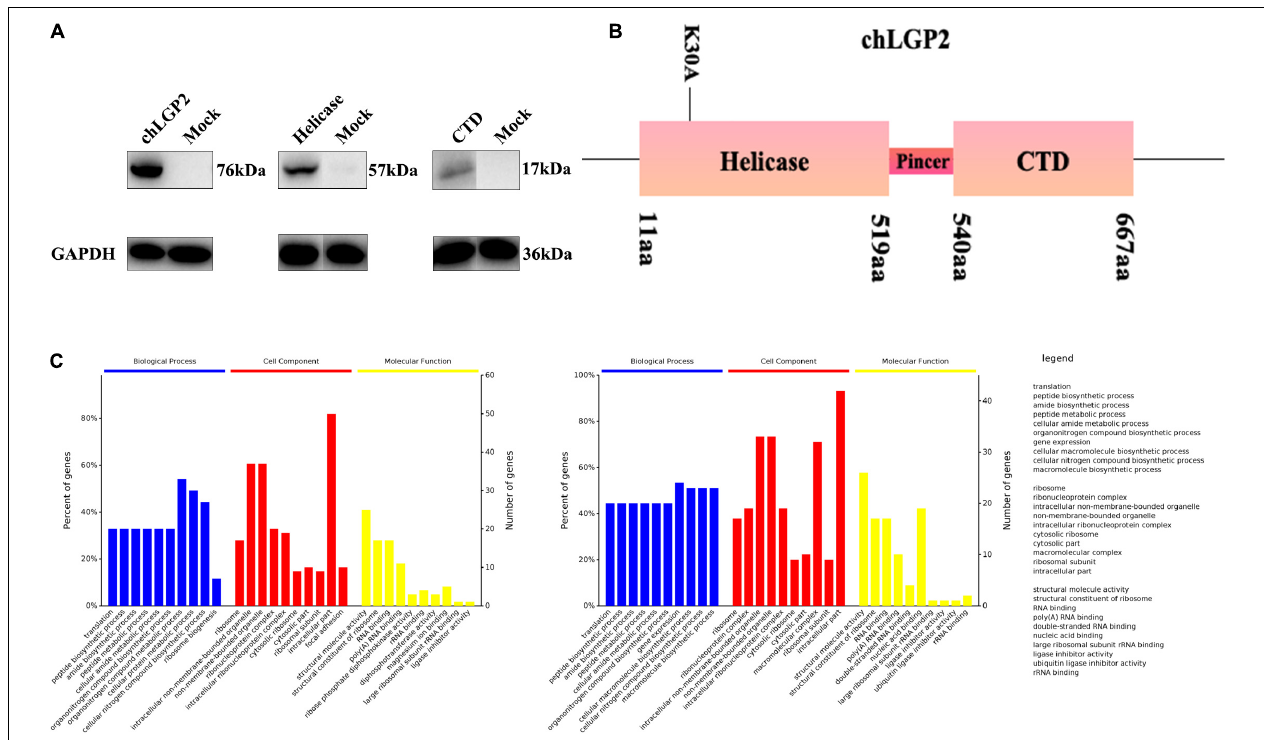
FIGURE 4 | The interaction between chLGP2 and chTRBP and the expression of chLGP2 domains. (A) Extracellular expression of chLGP2, Helicase domain, and CTD. (B) Schematic of different domains and the mutant K30A of LGP2. (C) GO enrichment analysis of chLGP2 bound proteins based on mass spectrometry